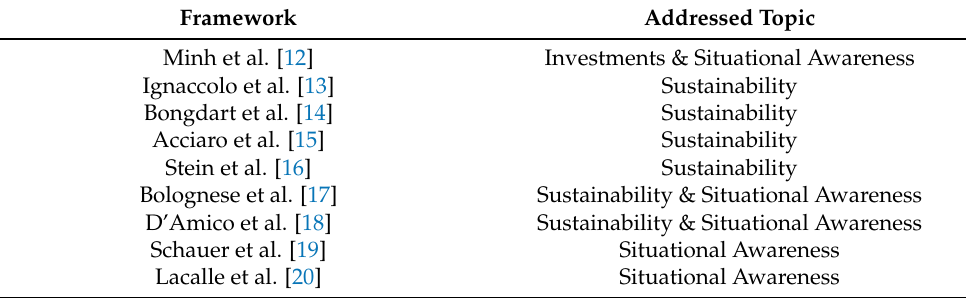
Table 1. Classification of available framework based on addressed